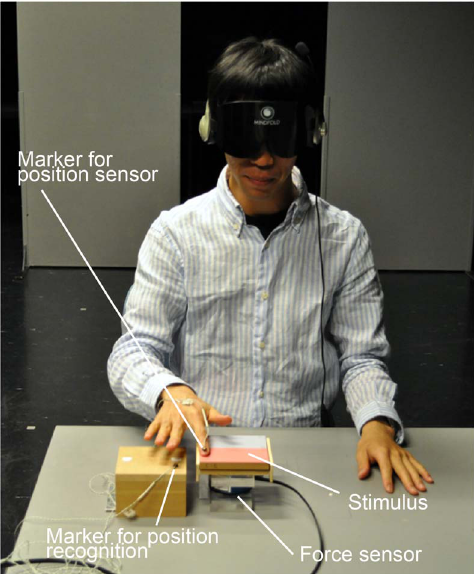
Figure 2. Experimental setup. Exerted force and position of the index finger were measured by the 6-axis force sensor and the 3D optical position sensor, respectively. The person in the photograph is not a subject in the study but is one of the authors demonstrating the procedure.